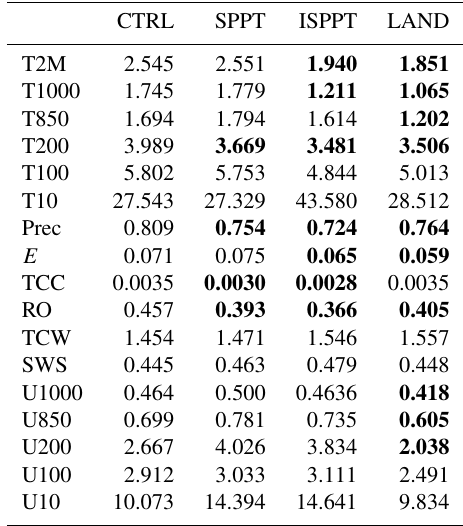
Table 2. Mean-square errors between the spatial means of the re- analysis (ERA40) and each EC-Earth configuration (CTRL, SPPT, ISPPT, and LAND) for T2M (2m temperature), T (temperature) at various levels (hPa), Prec (precipitation), E (evaporation), TCC (to- tal cloud cover), RO (total runoff), TCW (total column water), SWS (10m wind speeds), and U (zonal winds) at different pressure lev- els (hPa). Values where a stochastic scheme significantly reduced the error (see Sect. 3.2) are displayed in bold. CTRL SPPT ISPPT